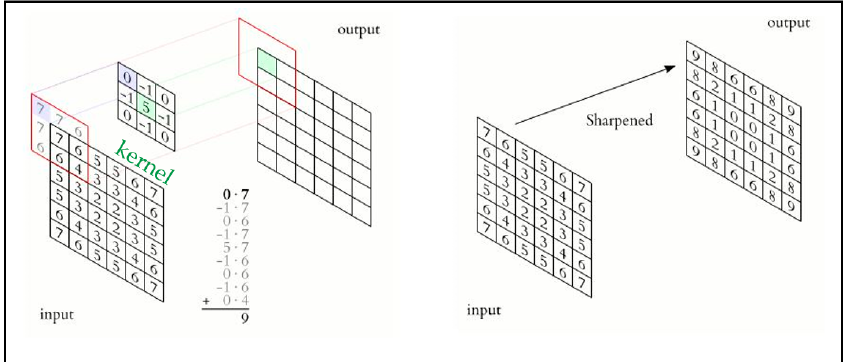
Figure 8. Example of convolution using a kernel.